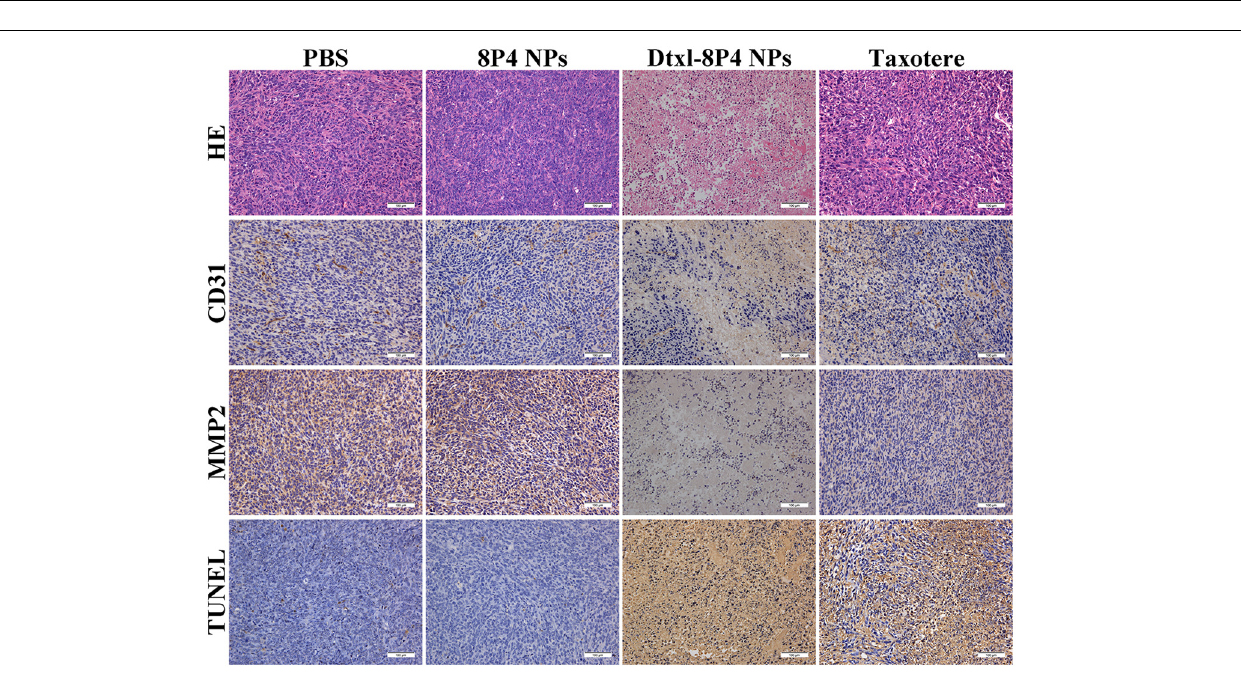
FIGURE 8 | HE staining analysis, CD31 and MMP2 expression and TUNEL examination of tumors from A549 tumor-bearing nude mice ( n = 5 per group) treated with PBS, 8P4 NPs, Dtxl-8P4 NPs, and Taxotere after a schedule of multiple doses (20 ×